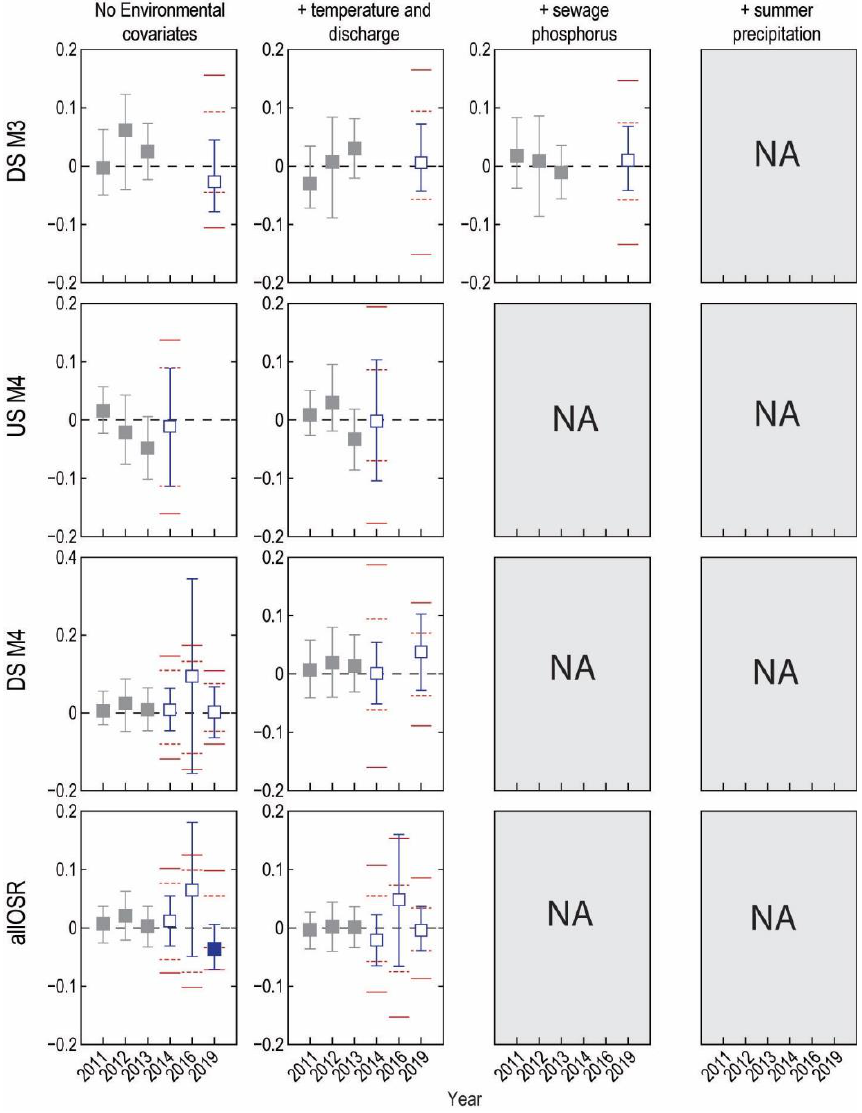
Figure 6. Median residual liver weight (LW) of male white sucker (±log10; g) from site-specific regressions done without environmental covariates, with T and D, with T, D, and P, and either T, D, P, and Pr, or T, D, and Pr; “NA” indicates a non-applicable analysis; upper and lower dashed horizontal red lines denote 97.5 and 2.5 percentiles, respectively; upper and lower solid horizontal dashed lines denote outer tolerance limits for the 97.5 and 2.5 percentiles, respectively; error bars in observed test and reference data show 95% confidence intervals; solid symbols suggest a potentially relevant difference; open symbols show potentially irrelevant differences; solid grey symbols denote baseline years (2011–2013) used to derive thresholds used for test years (2014, 2016, 2019).